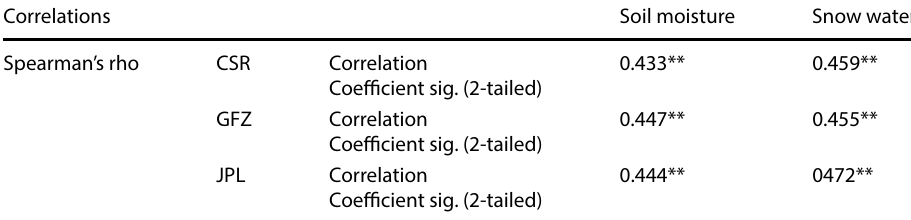
** Correlation is significant at 0.01 level